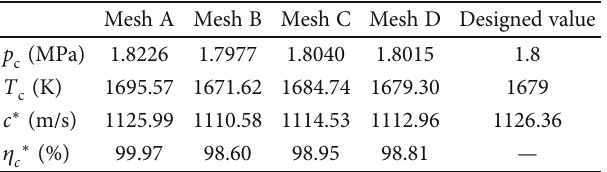
Figure 9: Cross-sectional averaged combustor temperature and species mass fraction (O combustor axis for di ff erent mesh resolutions. Table 4: Comparison of simulation results for di ff erent mesh resolutions and designed values.